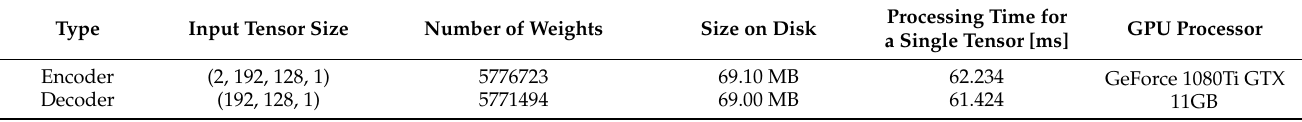
Table 6. Parameters of the encoder and decoder.